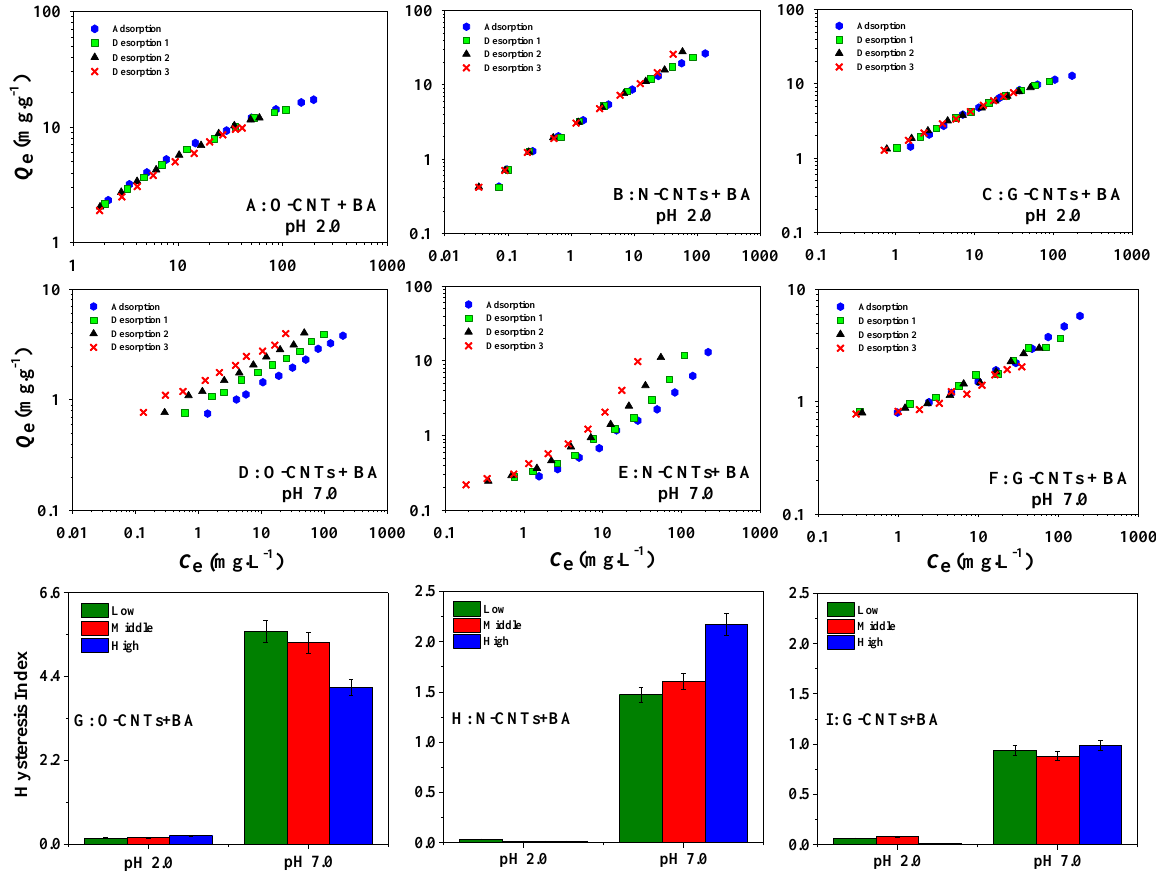
Figure 3. Adsorption and desorption of BA on O-CNTs, N-CNTs and G-CNTs at pH 2.0 ( A – C ) and pH 7.0 ( D – F ), respectively. And the comparison of the hysteresis index of BA (Low, Middle and High represent 5 mg · L − 1 , 80 mg · L − 1 and 160 mg · L − 1 of BA) on three types of CNTs ( G – I ) at pH 2.0 and pH 7.0. At Ph 2.0, there is no obvious desorption hysteresis of BA on three CNTs, but the obvious desorption hysteresis of BA on O-CNTs and N-CNTs occurred at pH 7.0. The hysteresis index of BA on O-CNTs ( ≥ 4.12) and N-CNTs ( ≥ 1.47) is higher than that of BA on G-CNTs ( ≤ 0.99) at pH